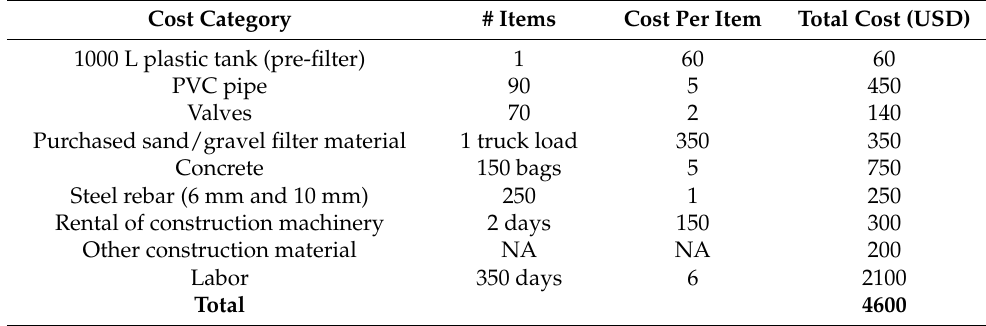
Table 1. IBF filter system costs in 2020